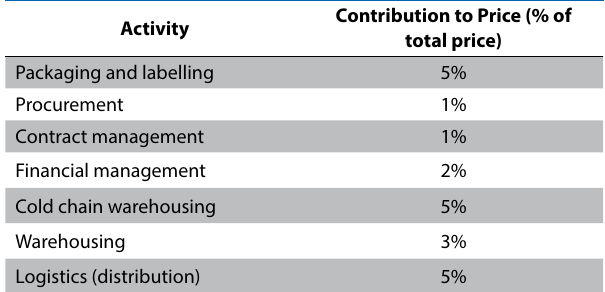
Table 4. Guidelines for contribution to vaccine price per activity Activity